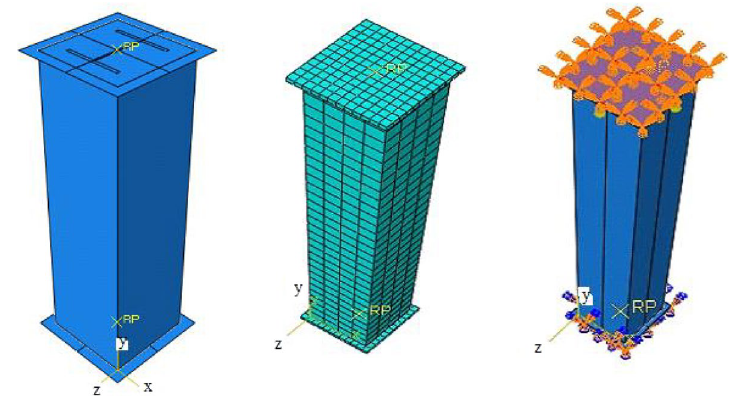
Fig. 3 Different stages of modeling by ABAQUS